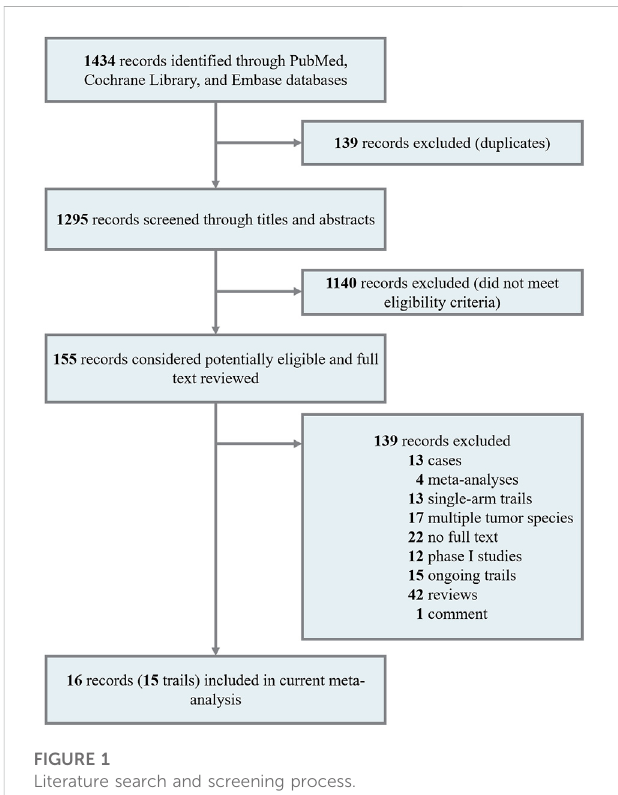
FIGURE 1 Literature search and screening